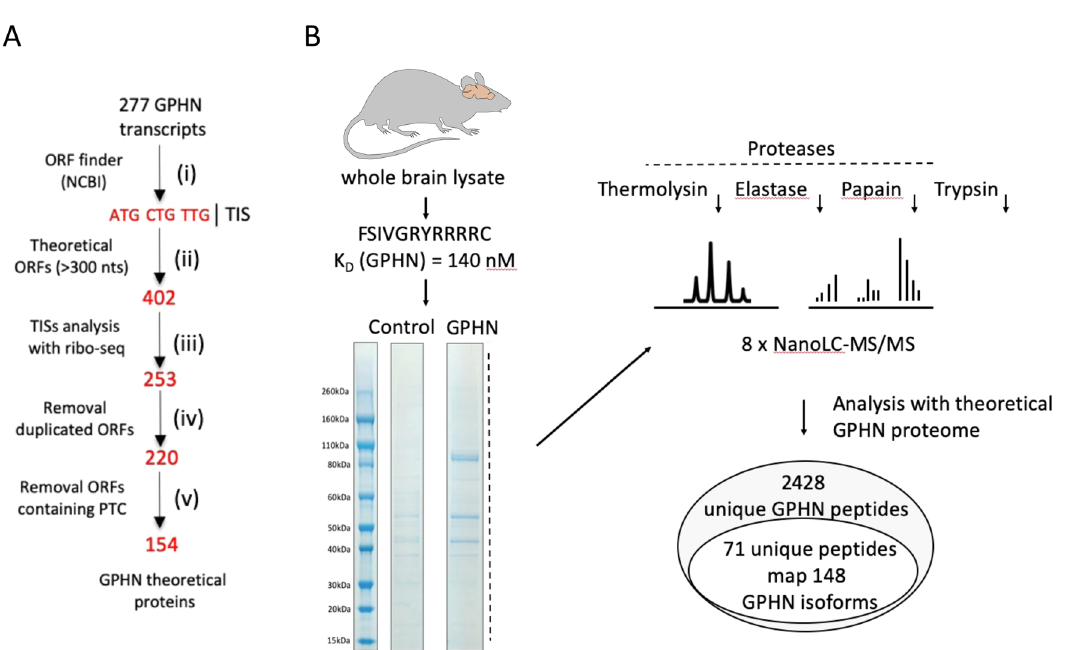
Fig. 2 Gphn expresses a myriad of GPHN protein isoforms. A Filtering pipeline used in this study to generate GPHN theoretical proteome, (i) Translation Initiation Start (TIS) identi fi cation, (ii) retained ORFs including at least 300 nucleotides, (iii) ORFs initiated with a TIS con fi rmed by biological evidences, (iv) removal of duplicated ORFs, (v) withdrawal of ORFs including PTC. B Work fl ow to isolate GPHN protein isoforms present at GABA- A and Glycine inhibitory synapses and MS processing to analyze them. GPHN was isolated from whole-brain lysate via af fi nity puri fi cation using a neurotransmitter receptor peptide (FSIVGRYRRRC; K D (GPHN) = 140 nM). Nano-LC MS/MS identi fi ed 2428 unique GPHN peptides, in which 71 corresponded to 148 novel GPHN protein isoforms. Source data are provided as a Source Data fi